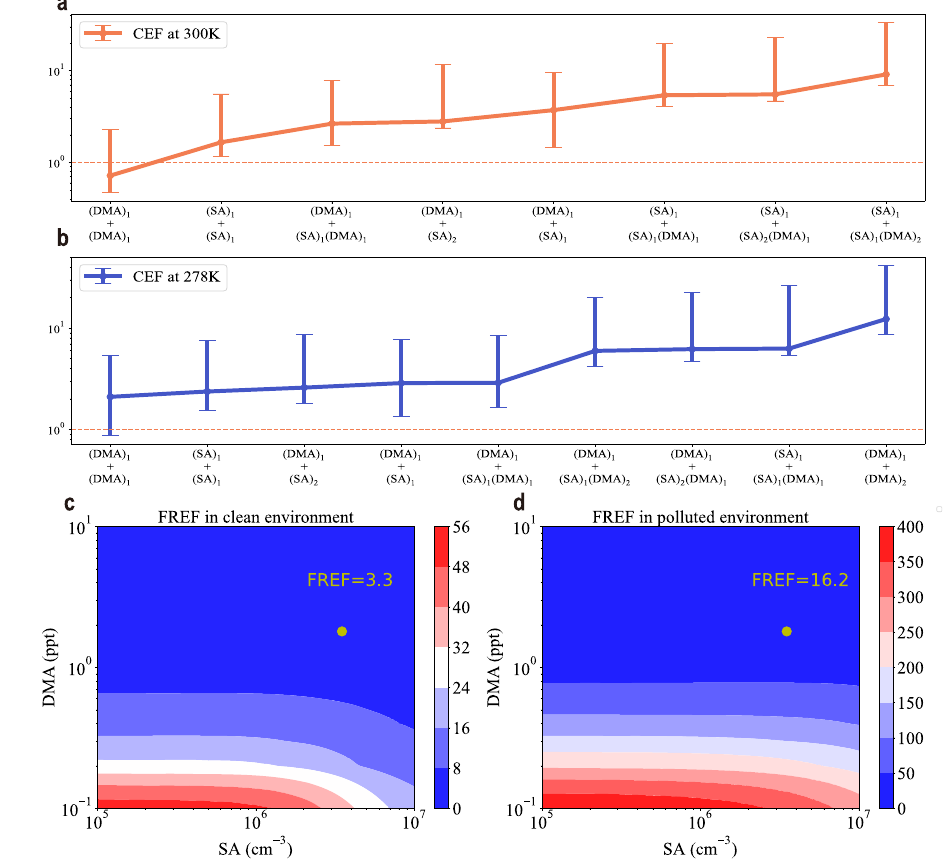
Fig. 4 | Collision and formation rate enhancement factor (CEF and FREF). a , b show the collision dependence of the CEF at 300 and 278K, respectively. The reaction list can be found in Supplementary Table 1. The error bars shown in a , b , which represent the upper and lower bound of CEF, result from a 95% con- fi dence level of Poisson-distributed reactions. Events c , d give the FREFs for representative clean (T=278K, CS=2.6×10 − 3 s − 1 ) and polluted environments (T=278K,CS=2.7×10 − 2 s − 1 ),respectively,whereTandCSarethetemperatureand